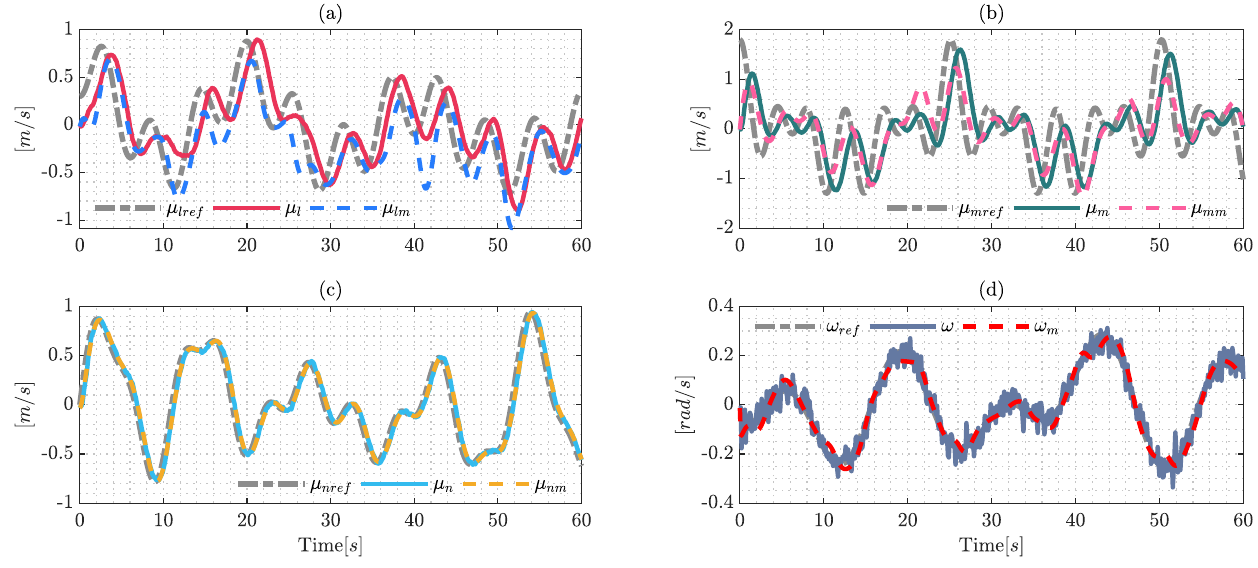
Figure 2. Signals of the identification process using the Euler-Lagrange formulation with the optimiza- tion techniques (SQPs). The results are confirmed by: ( a ) identification of the reference velocity µ lref ; ( b ) shows the results over the reference velocity µ mref ; ( c ) identification over the upper longitudinal velocity µ nref ; and ( d ) shows the results of the reference angular velocity ω ref